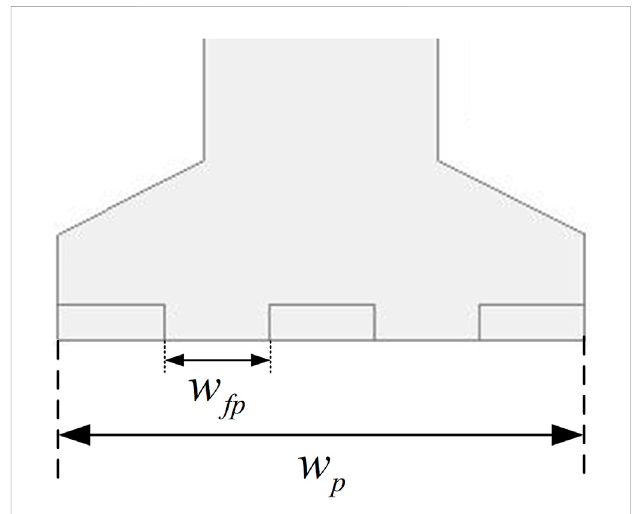
FIGURE 8 Primary ferromagnetic pole